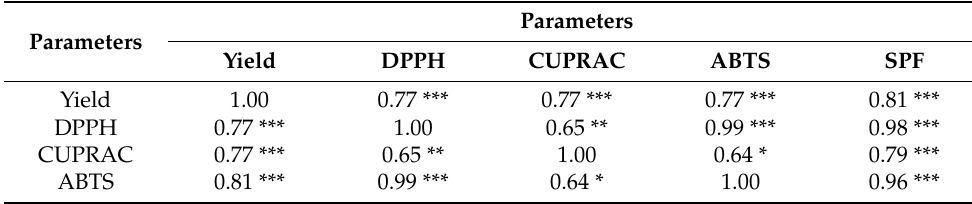
Table 2. The Pearson correlation coefficient among yields, antioxidant capacity, and SPF value of D.